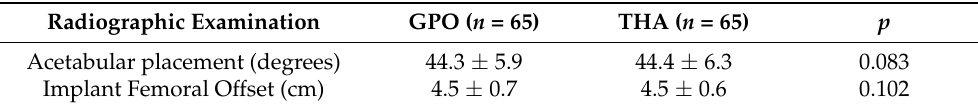
Table 2. Comparison of radiographic aspects baseline of the surgical procedure (GPO) and in the two-year post-operative period of total hip arthroplasty (THA) in older people with unilateral osteoarthritis.